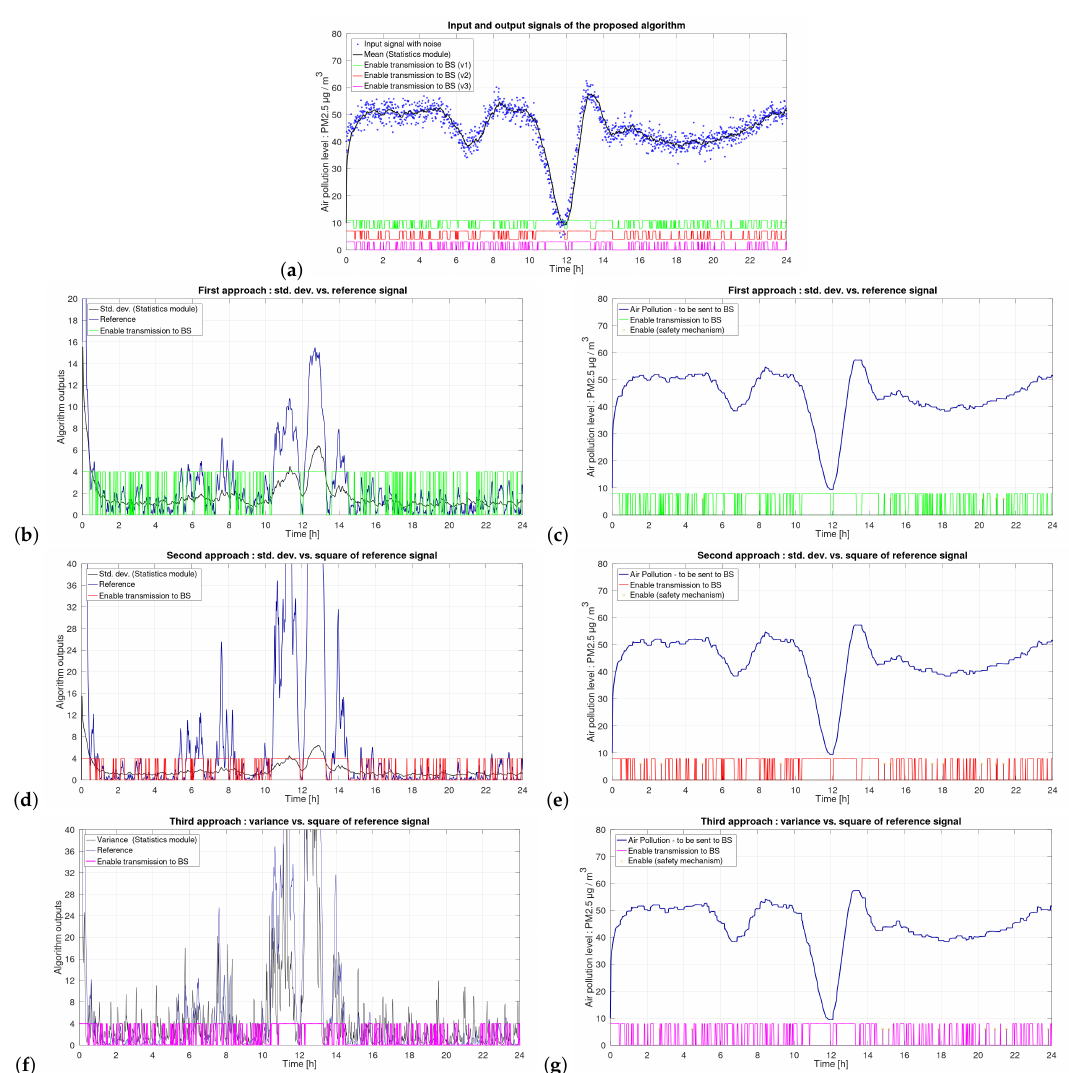
Figure 7. Simulation results of the proposed algorithm for medium noise levels of c. 12 PM2.5 µ g/m 3 (20%) and the values of K and N lpf2 of 8. ( a ) Input signal with noise, corresponding mean signal, as well as transmission enable EN1, EN2 and EN3 signals, for three approaches given by Equations (7), (8) and (9), respectively; ( b ) Standard deviation, reference ( y Ref ) and EN1 signals; ( c ) Sensor output signal transmitted to the base station (BS) for approach 1; ( d ) Standard deviation, square of reference ( y 2 ) and EN2; ( e ) Sensor output signal transmitted to the BS for approach 2; ( f ) Variance, square of Ref reference ( y 2 ) and EN3 signals; ( g ) Sensor output signal transmitted to the BS for approach Ref